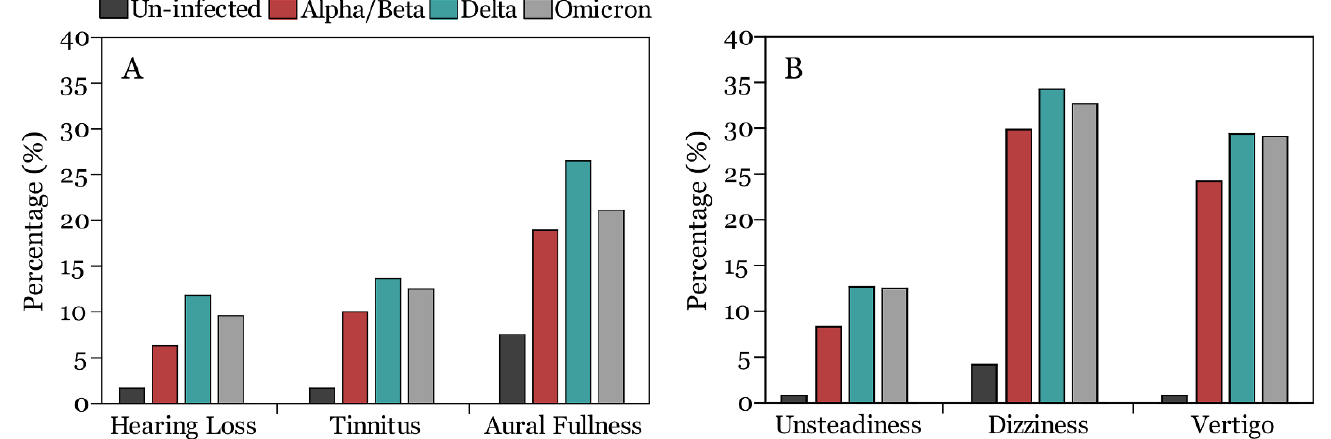
Figure 2. Frequency of auditory ( A ) and vestibular ( B ) symptoms among uninfected and infected participants when alpha/beta, delta, and omicron COVID-19 variants were dominant.